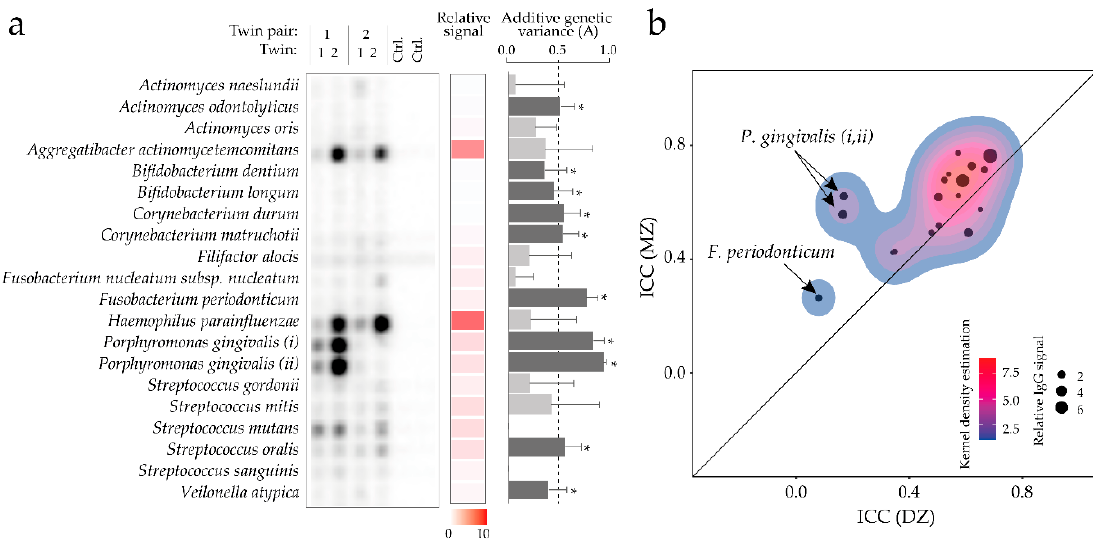
Figure 6. Serum IgG antibodies to oral bacteria. ( a ) show a representative checker-board analysis of two twin pairs and the negative controls (TBS) (left), heatmap for detection (middle), and bars representing additive genetic variance (A) estimates (right). Dark grey bars indicated significant attribution to additive genetic variance with the dotted line representing 50%; ( b ) scatter plot of intraclass correlation coefficient (ICC) of IgG antibody signals in MZ versus DZ twins. Each dot represents a single tested species with the dot-size indicating the IgG signal strength. The line represents the diagonal where X = Y. Density was predictable using the Kernel estimation. Mann–Whitney U tests were used for group comparisons. Error bars in ( a ) represents 95% CI. * indicates statistical significance p < 0.05 after adjustment for multiple comparisons. P. gingivalis ( i ) refers to strain W381, and ( ii ) refers to strain W83.